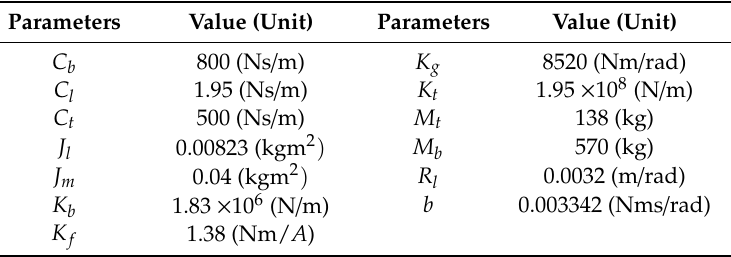
Table 1. Parameters of the servo feed drive system.